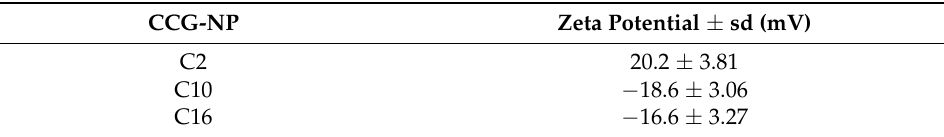
Table 1. Zeta potential of CCG-NP; mean ± S.D. ( n =